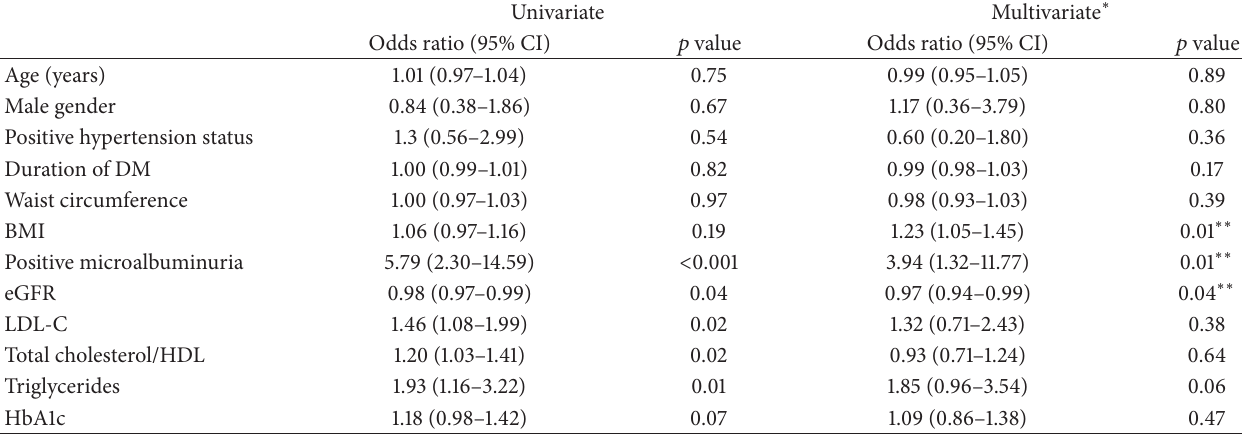
Table 4: Univariate and multivariate logistic regression models for factors predicting elevated 𝛽 2m.